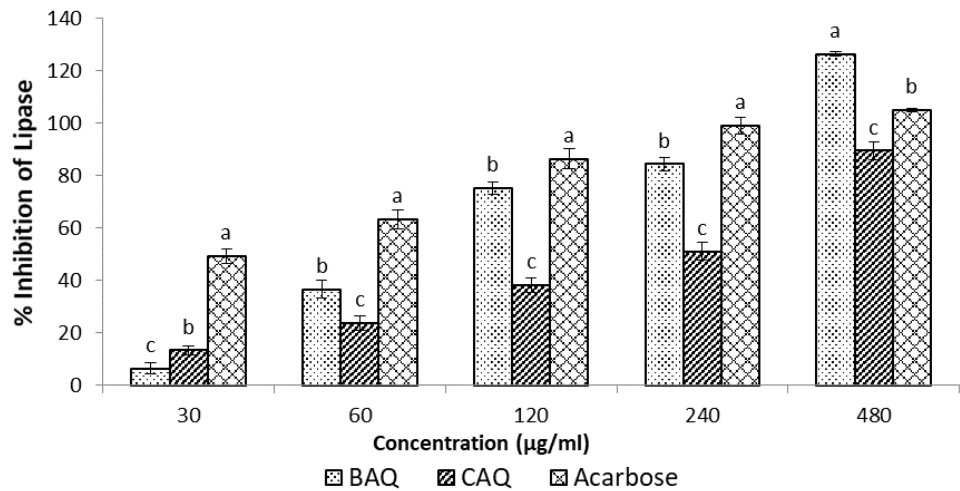
Figure 5. Inhibitory effects of the cold aqueous (CAQ) and boiled aqueous (BAQ) extracts of H. petiolare on lipase enzyme’s activity. Data expressed as mean ± SD (n = 3). Columns with the same alphabet within the same concentration are not significantly